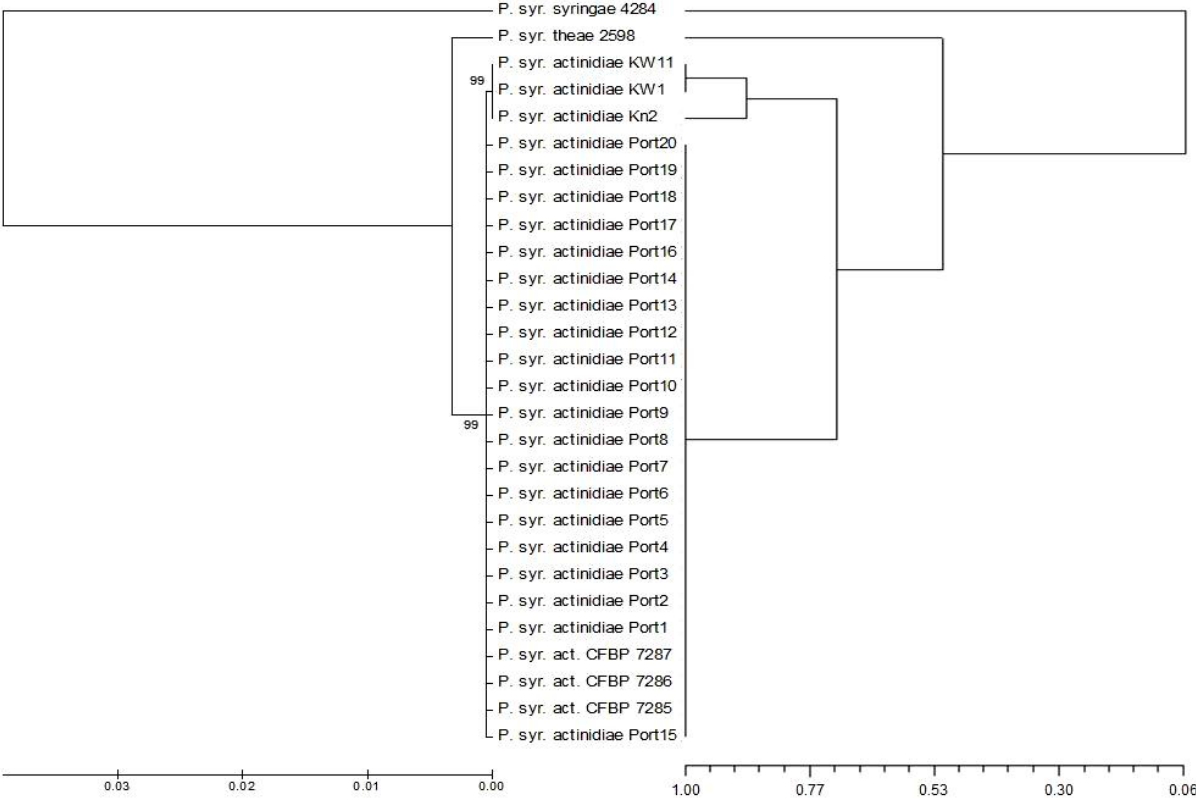
Figure 2. Comparison of results obtained by MLST (left) and fingerprint (right) analyses on 20 Portuguese Psa strains se - lected for molecular investigation and on reference strains (see Table